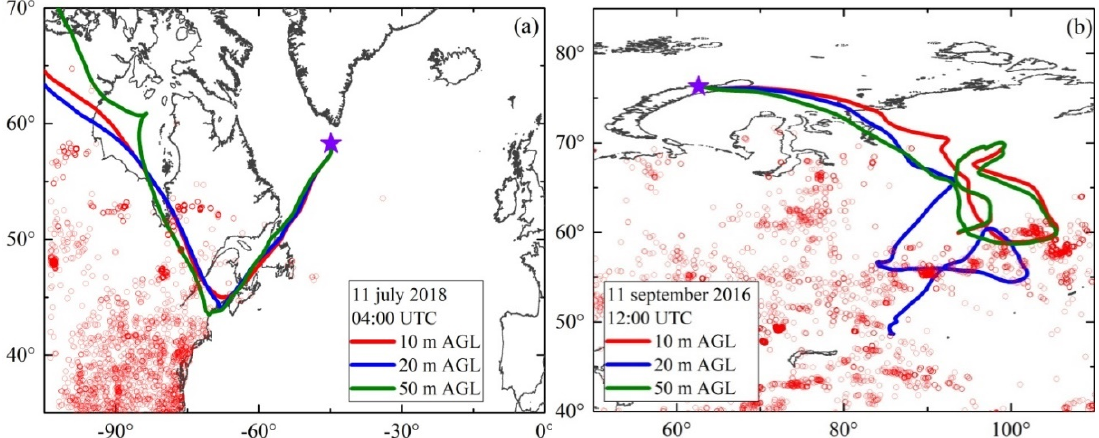
Figure 7. Back trajectories of air mass motion to the measurement sites (stars) at heights of 10, 20 and 50 m above ground level (AGL) in the situations on 11 July 2018 in the North Atlantic ( a ) and 11 September 2016 in the northeastern part of the Barents Sea ( b ); red dots indicate fire centers (temperature anomalies).